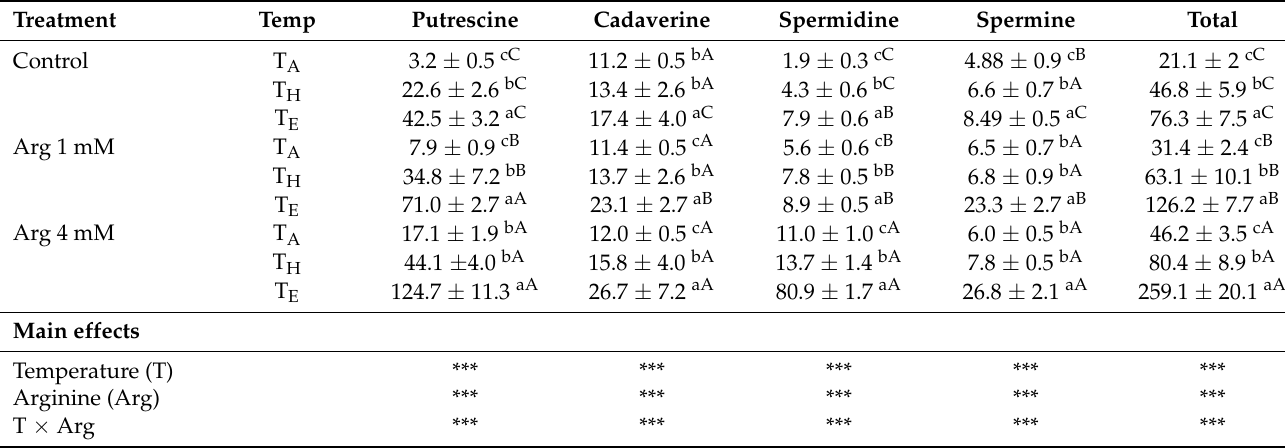
Table 7. Polyamine content (nmoles g − 1 FW) of cauliflower florets affected by short-term heat stress and foliar arginine application.